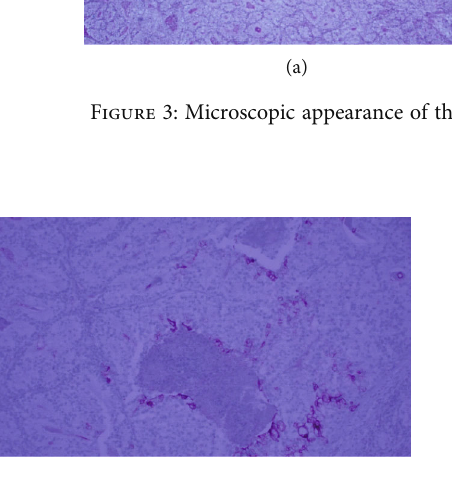
Figure 4: Focal distribution of CK20 positive staining in the tumor (100 × ).